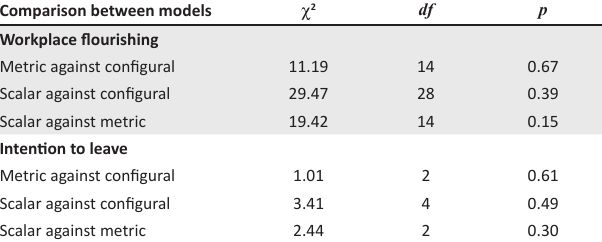
TABLE 4: Longitudinal measurement invariance.